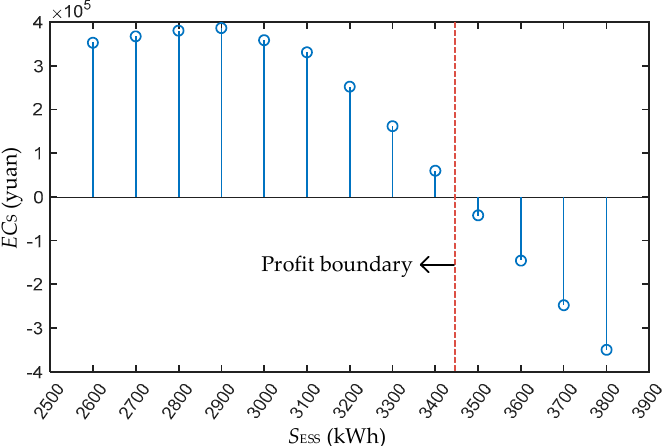
Figure 4. ESS charging and discharging results in the base case.